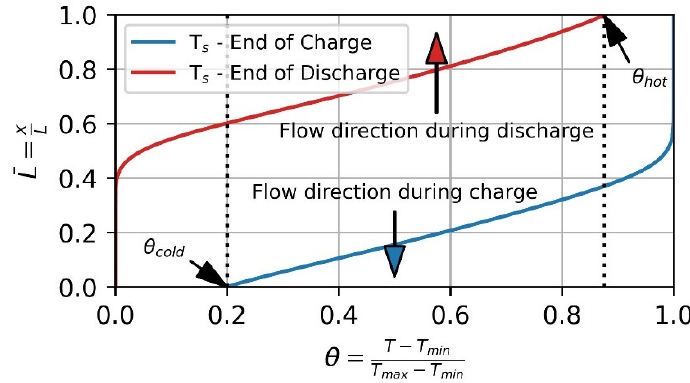
Figure 4. Temperature profile at the end of charge (blue) and end of discharge (red) for the solid phase. Threshold values θ cold and θ hot for the gaseous phase outlet temperature during charge and discharge, respectively. The ordinate represents the normalized storage height L (cid:3365) and the abscissa corresponds to the dimensional temperature θ .